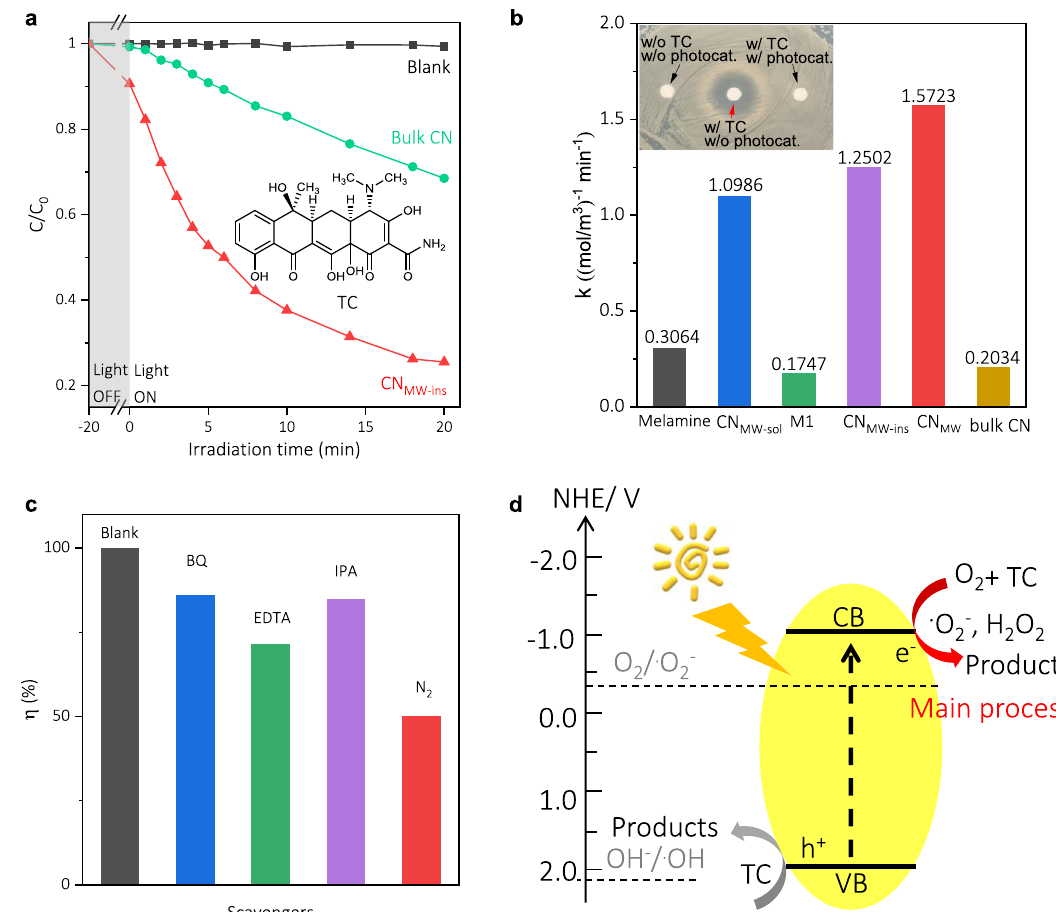
Fig. 2 Photocatalytic sanitation of TC-contaminated water by CN. a Absorbance of TC at 357 nm as a function of time during photocatalytic oxidation reaction (>400 nm) using bulk CN and CN MW-ins catalyst. b Pseudo-second-order reaction kinetics for TC sanitation using different photocatalysts. Inset: bactericidal halo test. “ w/ ” and “ w/o ” denote “ with ” and “ without, ” respectively. c Photocatalytic activity of CN MW-ins for TC sanitation in the presence of different scavengers. d Proposed mechanism of photocatalytic oxidation of